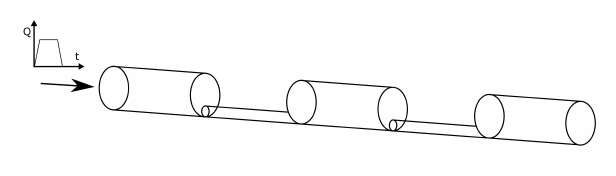
Figure 4. The Rossman [56] test